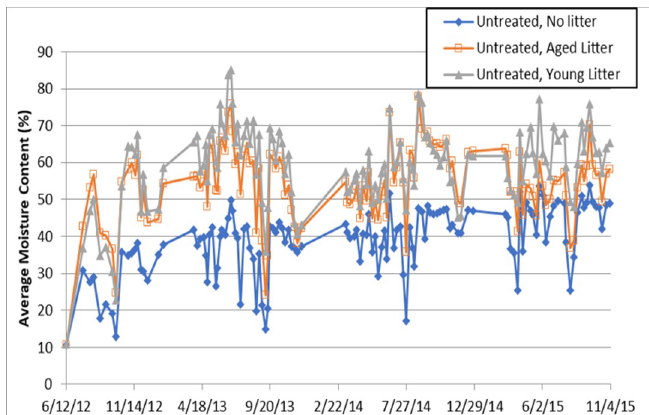
Figure 3. Average moisture content for unexposed wood blocks compared to wood exposed to aged and young leaf litter ( n = 5). Note higher swings in moisture content when leaf litter is present and slightly higher moisture content (MC) in aged vs. young litter. Error bars omitted for readability. Average standard errors were 2.4%, 4.20%, and 3.63% for no leaf litter, aged leaf litter, and young leaf litter, respectively.